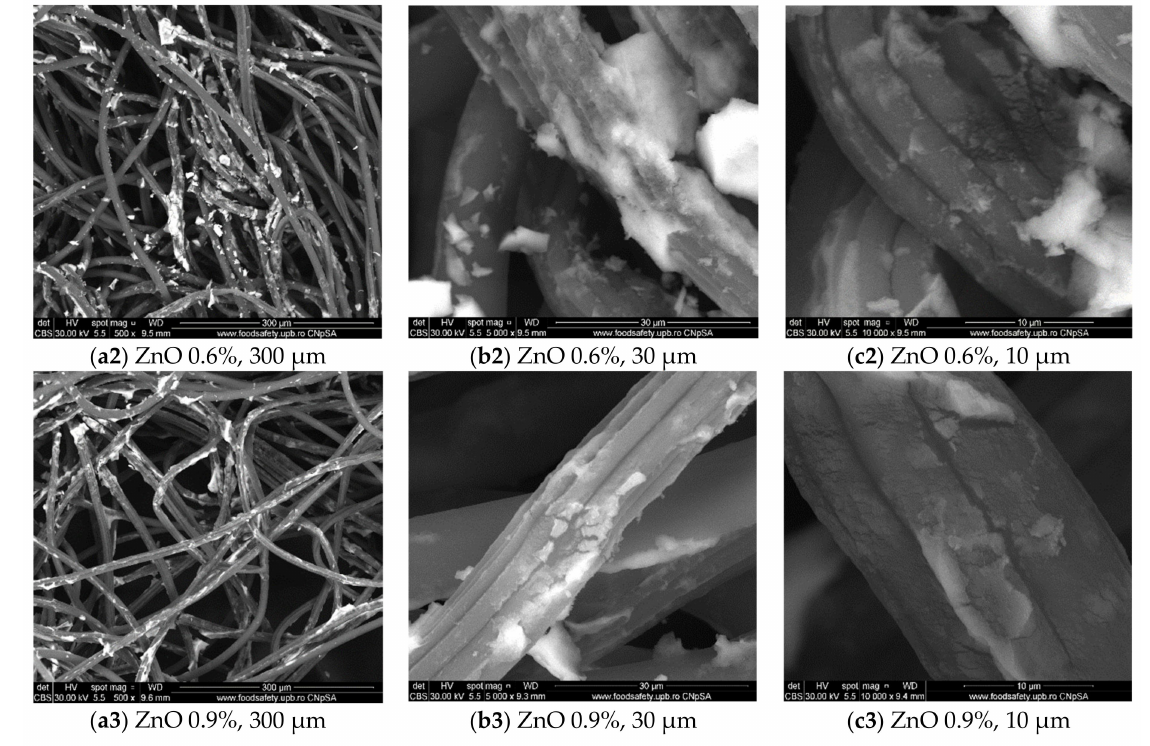
Figure 1. SEM images of the ZnO NPs-coated dressings (ZnO 0.3%; 0.6%; 0.9%) at various similar magnification (( a1 – a3 ) = scale is 300 µ m, ( b1 – b3 ) = scale is 30 µ m, ( c1 – b3 ) = scale is 10 µ m).